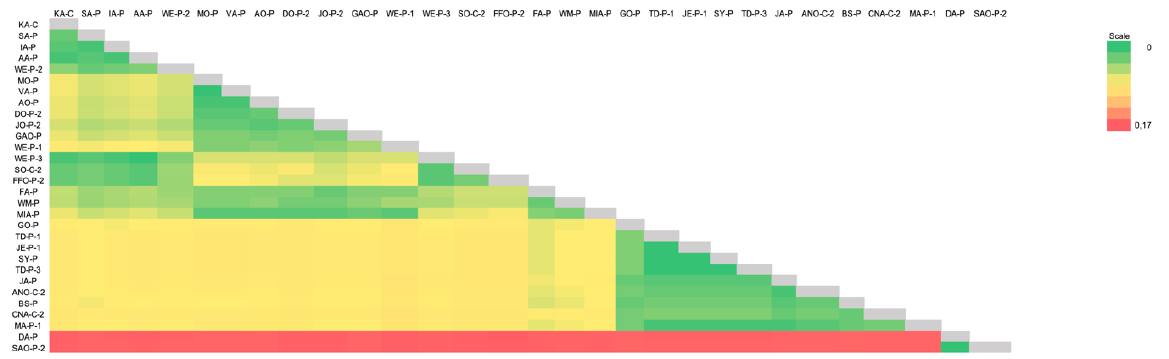
Figure 10. A heatmap constructed using the distance matrix based on p -value between all sequences obtained herein. The scale on the right demonstrates the color shade transition between obtained values.